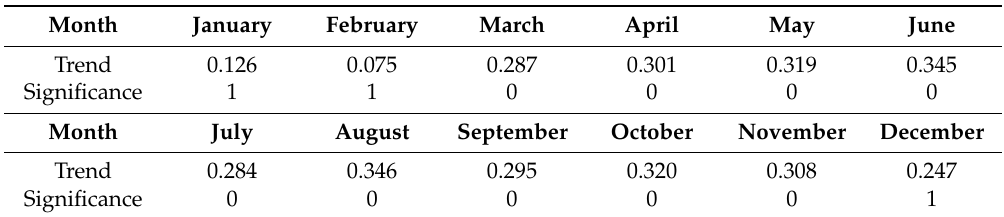
Table 2. AT monthly trend according to Mann-Kendall method during 1950–2010 (60 years) (meter per month ( m / m )).